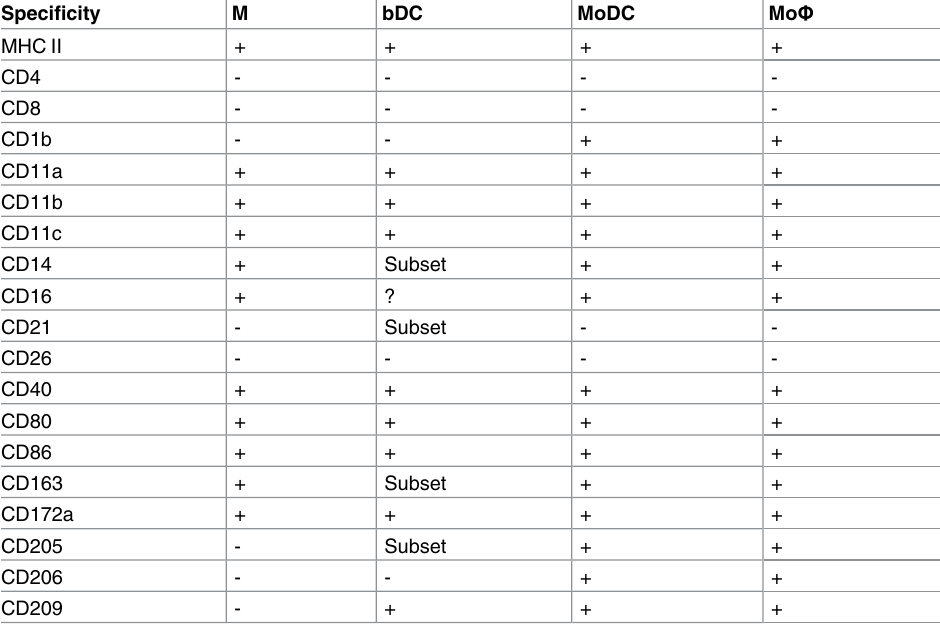
Table 2. Phenotype of monocytes, bDC, MoDC, Mo Φ